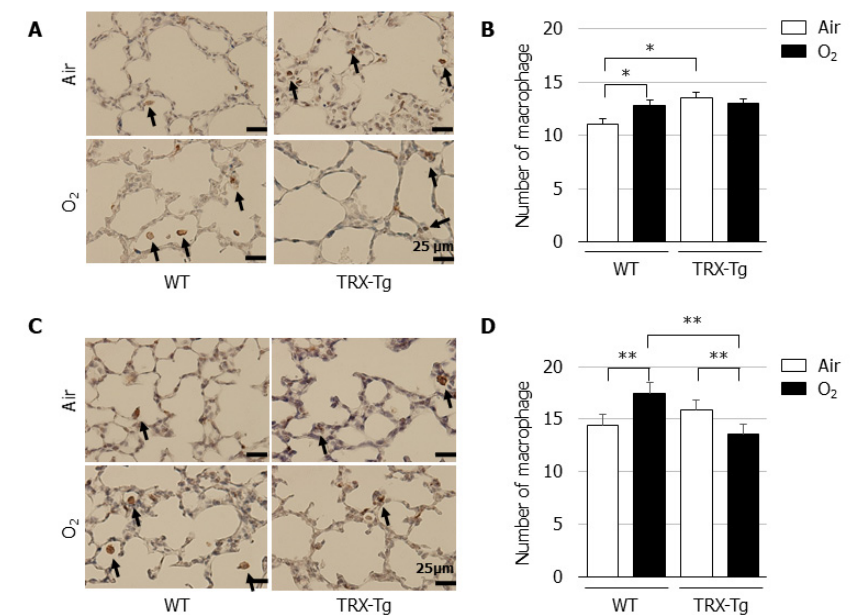
Figure 5. Immunohistochemistry for macrophages. Immunohistochemistry using the macrophage marker F4/80 was performed on lung sections on ( A ) day 4 and ( C ) day 14. The black arrows indicate F4/80-positive macrophages. Scale bar = 25 µm (magnification × 400). Number of macrophages on ( B )